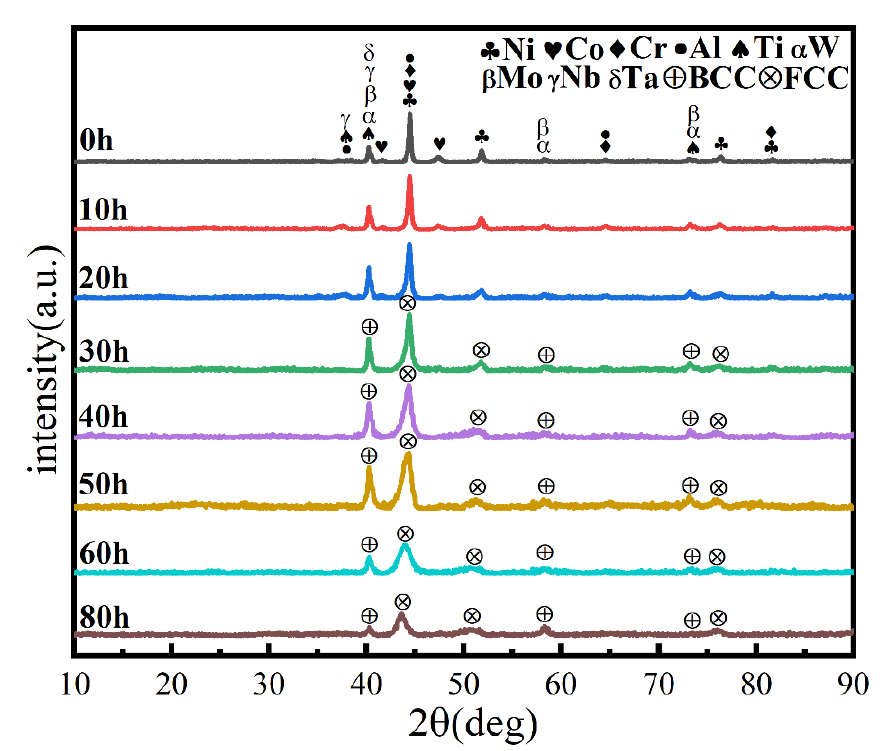
Figure 4. XRD patterns of powders at different milling times with a milling speed of 500 r min −1 and ethanol PCA.